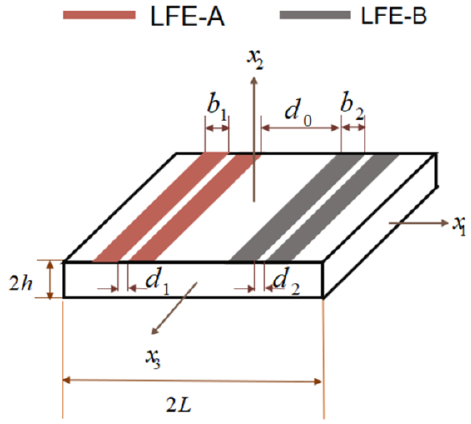
Figure 1. Structure diagram of LiTaO 3 LFE bulk acoustic wave array devices.